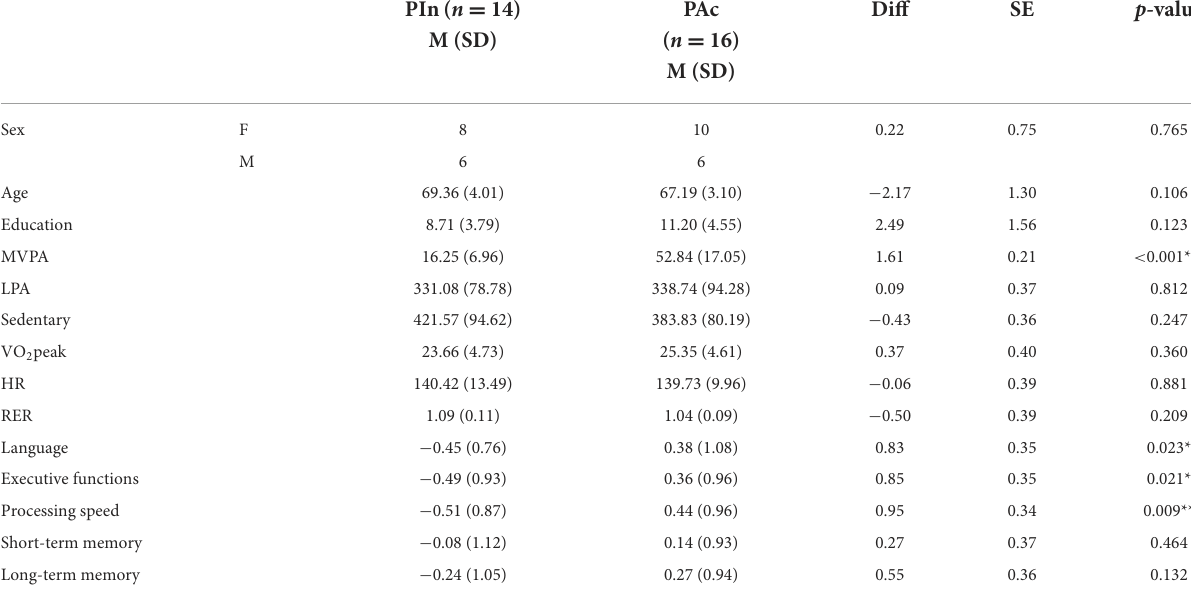
TABLE 3 Between-groups differences, comparing the PIn group (reference level) to the PAc